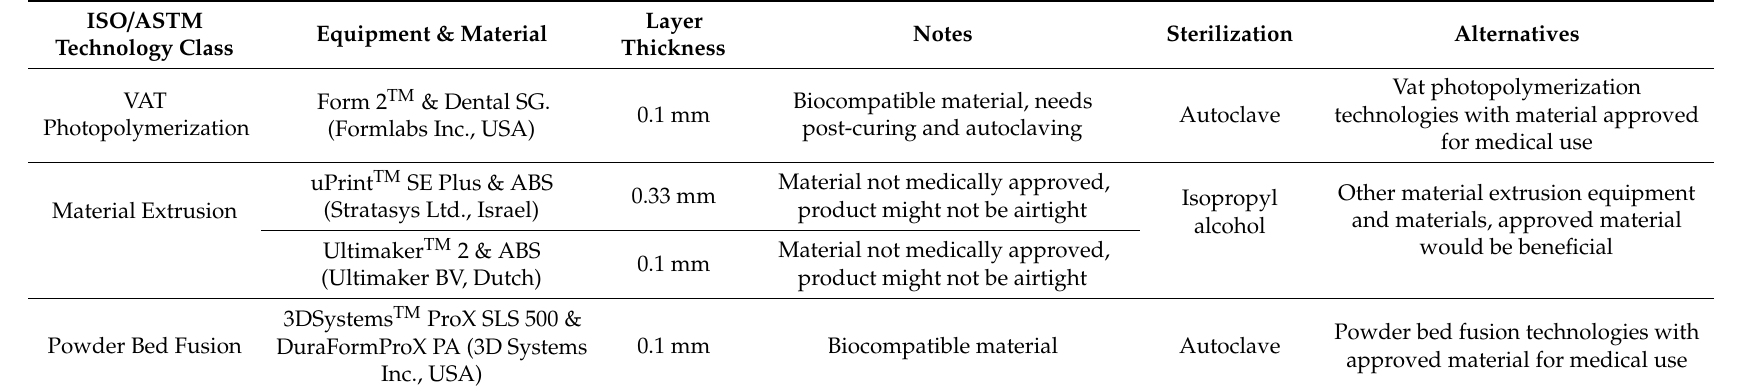
Table 2. 3D Printing technologies and